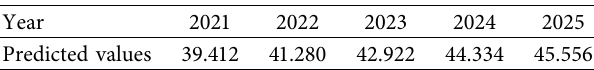
Table 5: Prediction of China’s e-commerce transaction volume (unit: trillion Chinese Yuan).